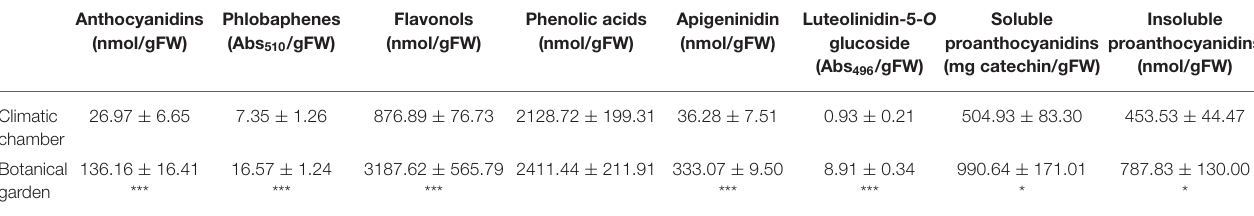
TABLE 1 | Polyphenol signature detected by spectrophotometric analyses in A. filiculoides sampled outdoor in February 2020 as compared with the fern grown in the climatic chamber (220 PPFD of light intensity; 10-h photoperiod, 25/20 ◦ C day/night temperature). Anthocyanidins Phlobaphenes Flavonols Phenolic acids Apigeninidin (nmol/gFW) (Abs 510 /gFW) (nmol/gFW) (nmol/gFW) (nmol/gFW)